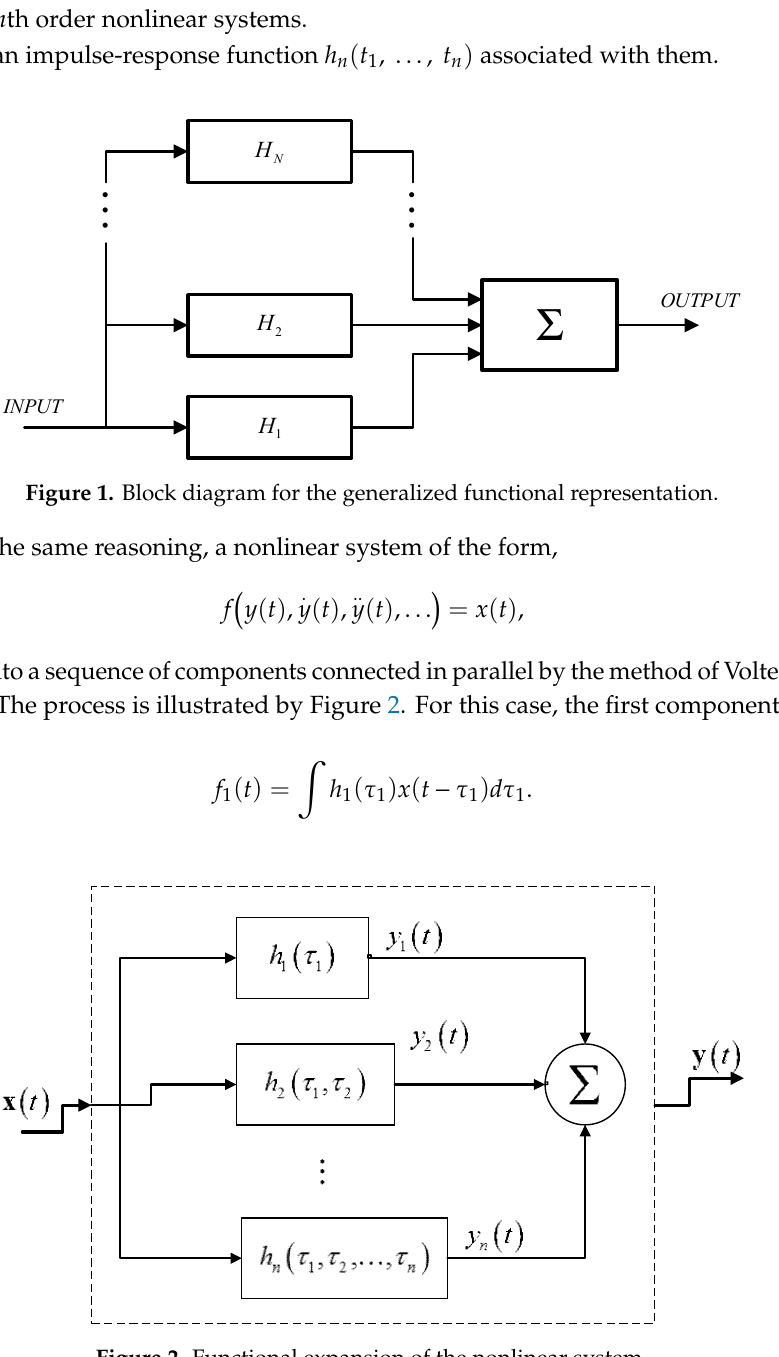
Figure 2. Functional expansion of the nonlinear system.